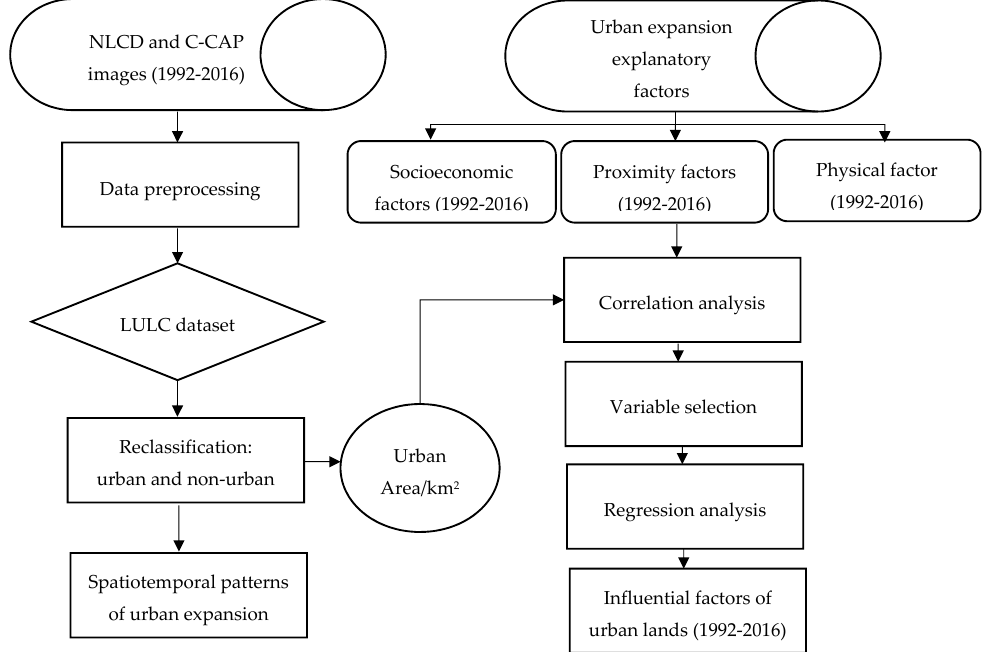
Figure 2. Methodological flowchart of the study.